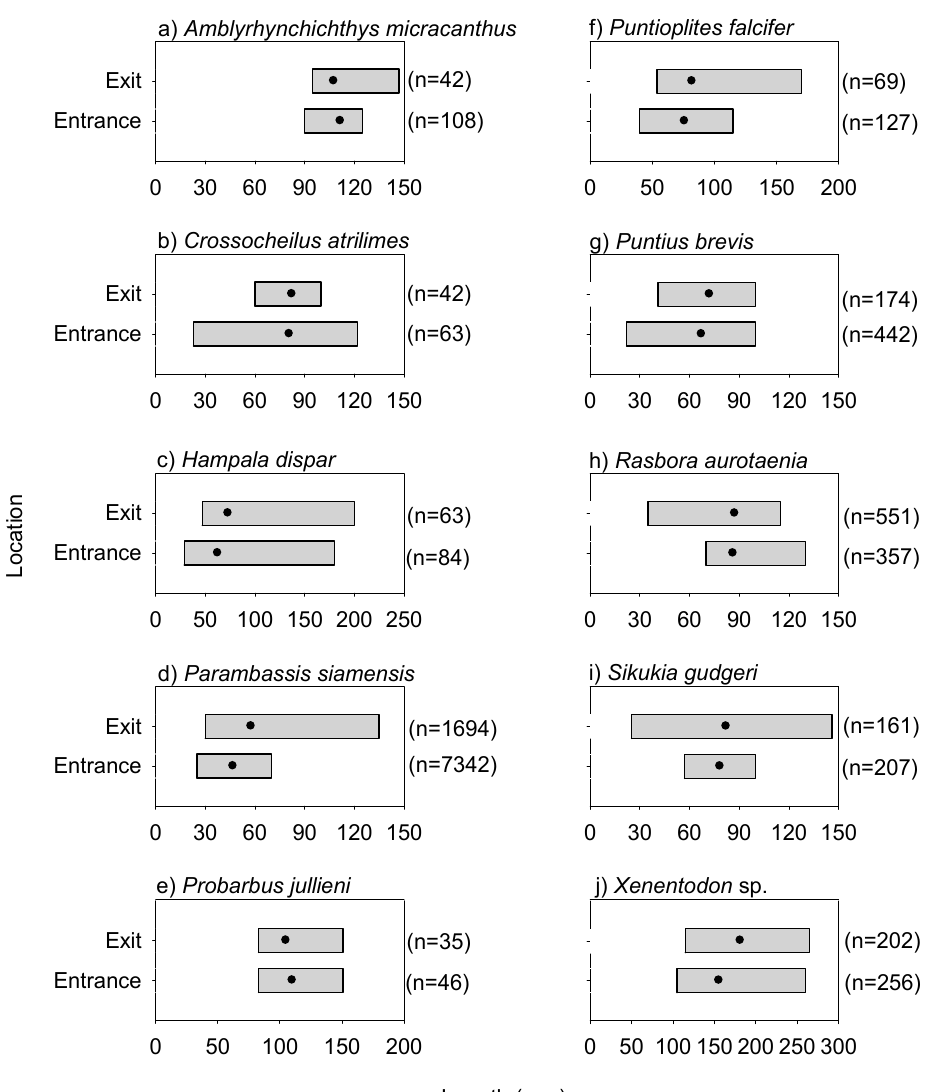
Figure 4. Length ranges of common fish species at the entrance and exit locations for the day experiment. Note, the solid black circles represent the mean values. Common species refers to the 10 most prevalent species (based on sample occurrence) recorded during both day and dusk/night experiments. Table 1. Average prevalence (i.e., proportion of occurrence in samples) of species identified by SIMPER during the day experiment as important in contributing to between-treatment dissimilarity in community composition (based on presence-absence transformed community data). Each species contributed at least 2% of total dissimilarity and had a dissimilarity-to-standard deviation ratio of ≥ 1.